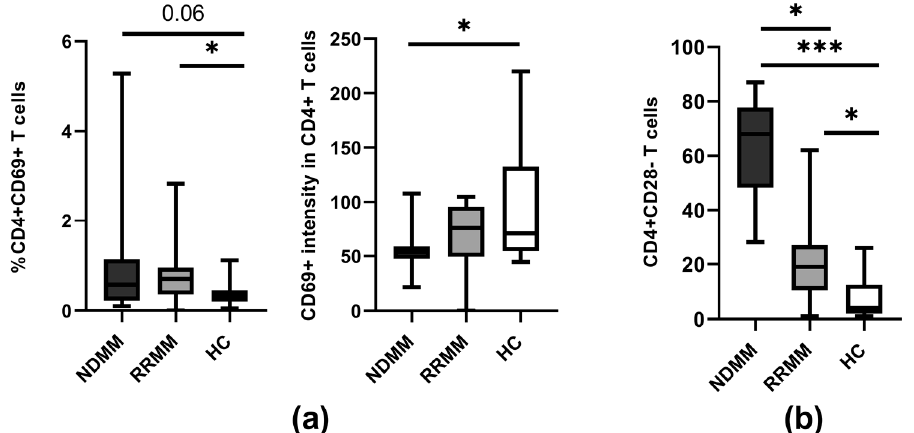
Figure 5. Markers of CD4 T cell reactivity. ( a ) Expression of the CD69 activation marker on CD4 + T cells in PB of healthy controls (HC) (n = 20) and patient subgroups (NDMM and RRMM) (n = 26 and n = 14, respectively). ( b ) Frequency of CD28 lacking CD4 + T cells at the different MM stages. Boxes and whiskers show 25th and 75th interquartile range and minimum–maximum, respectively; the median is the central line in each box. The differences between the studied groups were statistically evaluated using Kruskal–Wallis, ANOVA, and Mann–Whitney U tests. * p < 0.05, *** p < 0.001.